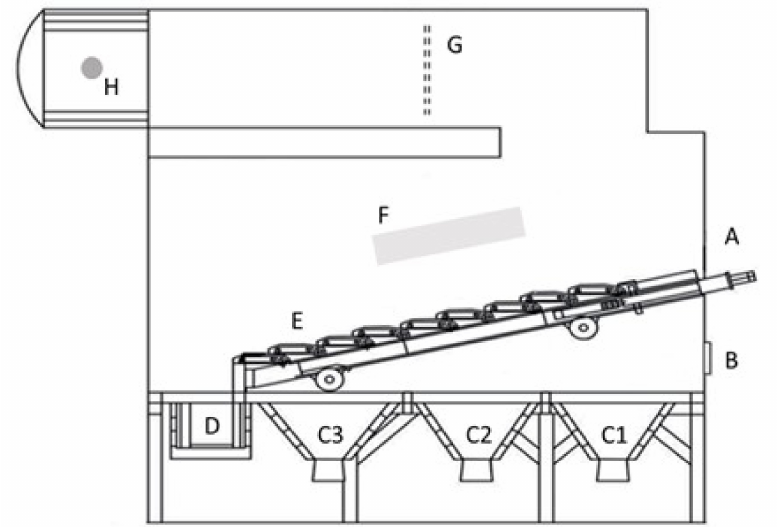
Figure 2. A modified [33] schematic picture of the HOTAB / Saxlund 8MWth sloping reciprocating grate furnace at Uddevalla Energy AB, Sweden. A) fuel inlet, B) glass window, C1–C3) Box 1 to Box 3, D) ash outlet, E) reciprocating grate, F) secondary air ports, G) tertiary air ports, H) exit of the